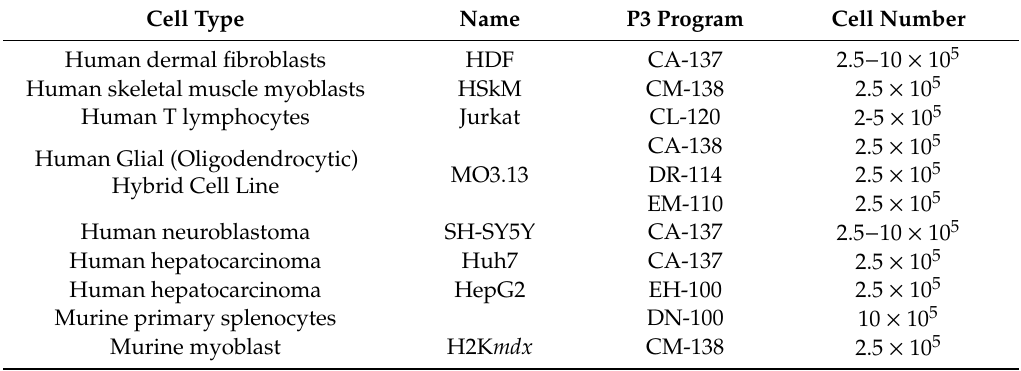
Table 1. Optimal nucleofection programs for the P3 kit and the cell numbers tested in specified cell lines. Cell